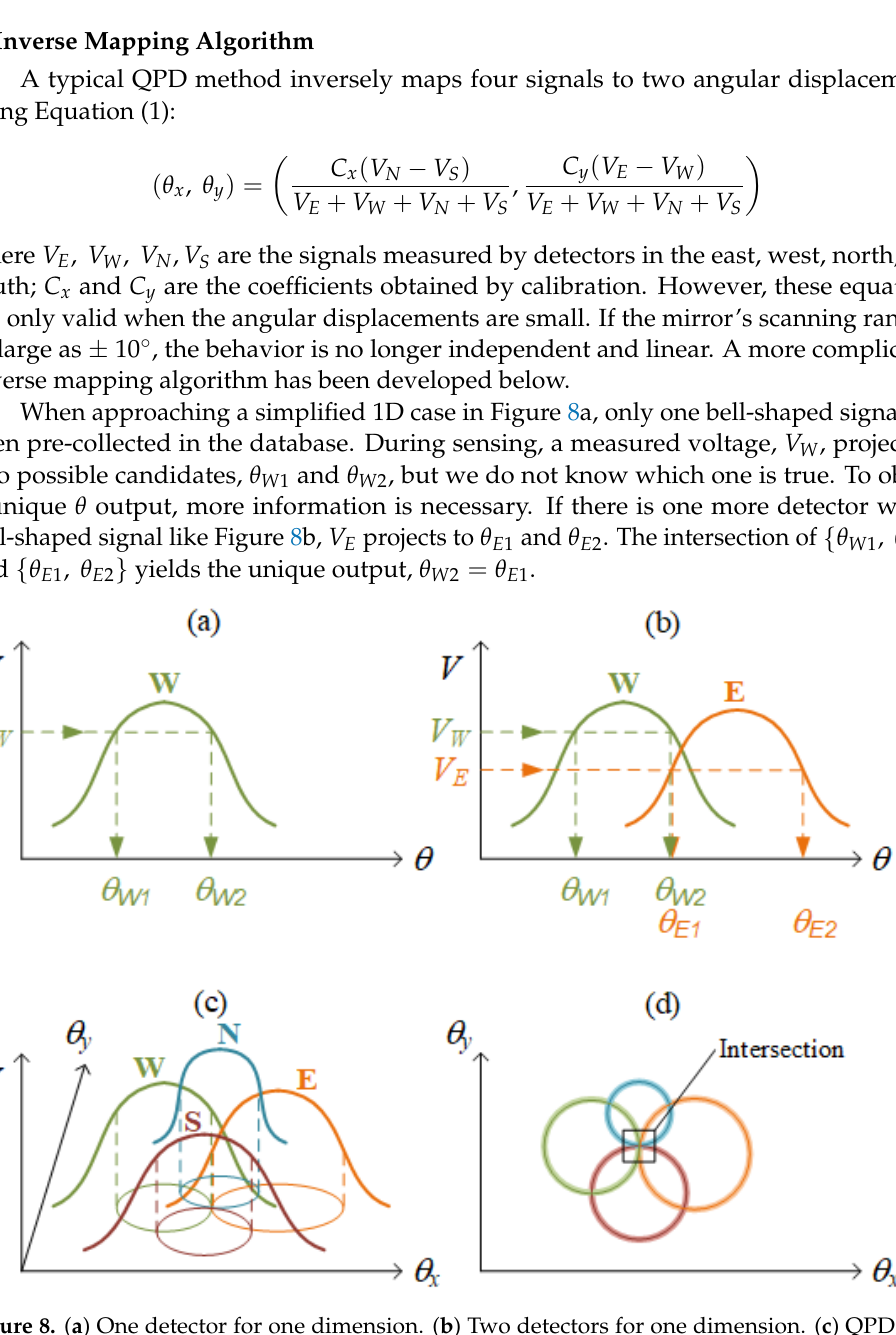
Figure 8. ( a ) One detector for one dimension. ( b ) Two detectors for one dimension. ( c ) QPD: four detectors for two dimensions. ( d ) The intersection of four hoops contains multiple candidates.